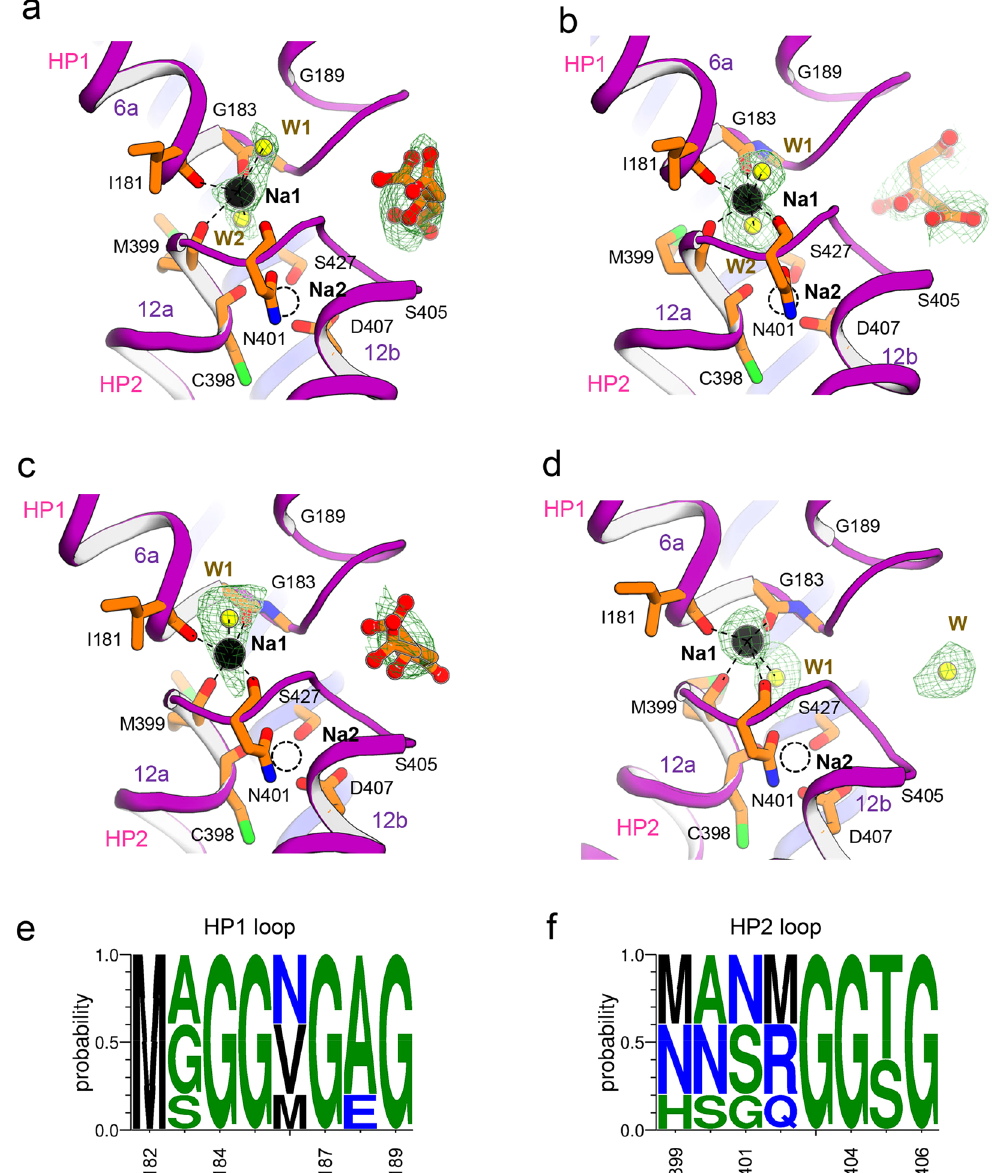
Figure 6. The sodium ion binding sites in Kp CitS. ( a ) The outward-facing protomer in the asymmetric conformation. ( b ) The inward-facing protomer in the asymmetric conformation. ( c ) The protomer in the outward-facing conformation. ( d ) The protomer in the inward-facing conformation. Citrate is shown as an orange ball-and-stick model, sodium ions (Na1) as black spheres, and water molecules (W, W1, W2) as yellow spheres. The empty Na2 sites are shown as dashed spheres. Hydrogen bonds and ionic interactions are drawn as dashed lines. The simulated annealing omit maps superimposed on the refined citrates, sodium ions, and water molecules were contoured at 2.8 σ level. ( e , f ) WebLogo representations of the sequence alignments and conservation in the HP1 and HP2 loops of 2-HCT proteins 54, 55 . The amino acid positions in the multiple sequence alignment are: Kp CitS (182–189, 399–406), Se CitS (182–189, 399–406), Bs CimH (191–198, 403–410), Lm CitP (186–193, 396–403), and Ll Melp (169–176, 378–385) for the HP1 and HP2 loops,